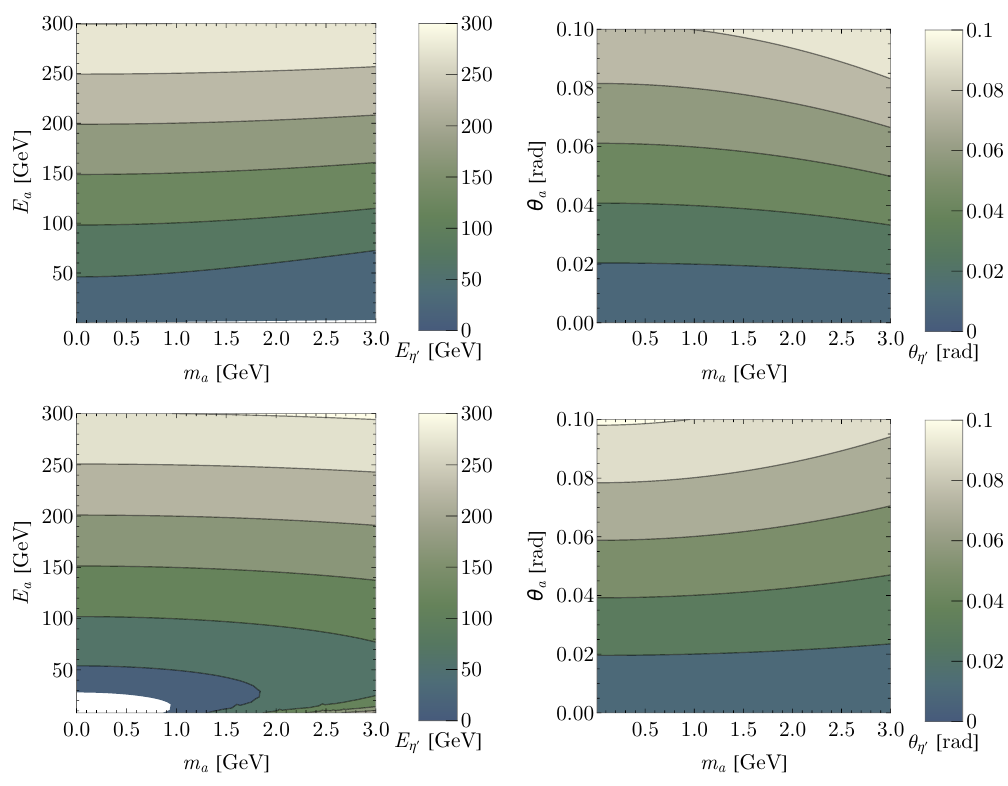
Figure 9 . Dependence of the energy (left) and the angle of the ALP (right) on the ALP mass in the laboratory frame for the case of the fixed momentum (upper panel) or fixed energy (lower panel) in the p - p cm frame when the original particle was the η 0 meson, produced by a 400 GeV proton beam. The angular distribution is evaluated for the case E = 100 GeV a